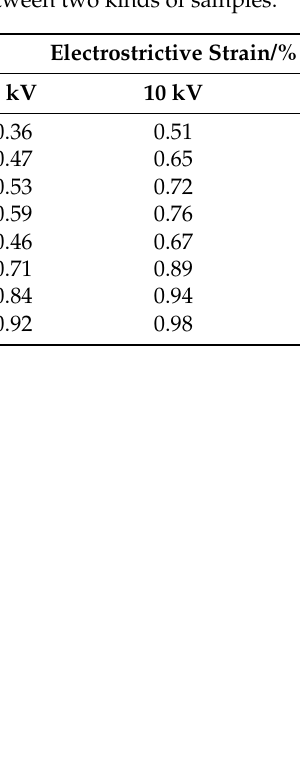
0.0 Figure 6. Comparison diagram of electrostrictive strain between two kinds of samples. Figure 6. Comparison diagram of electrostrictive strain between two kinds of